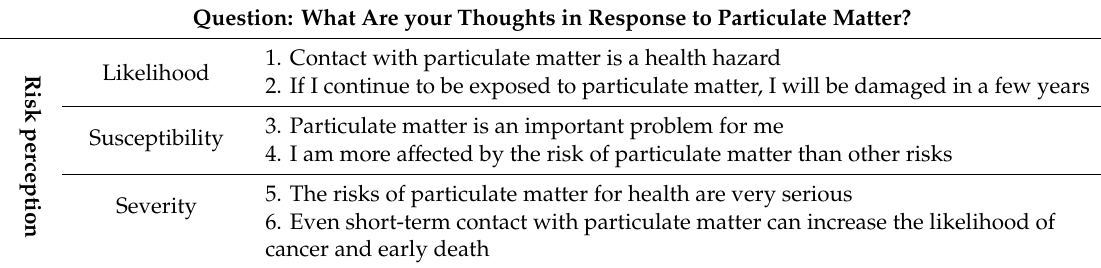
Table 5. Psychological